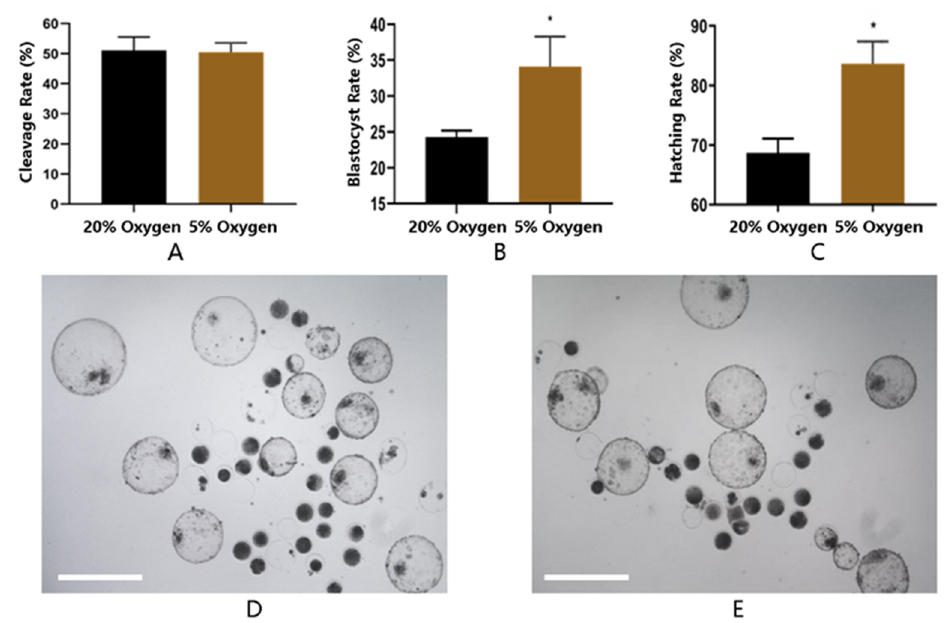
Figure 1. Effect of varying oxygen levels (20% vs. 5%) on embryo development. All the experiments were repeated three times. Embryos were cultured in 20% ( n = 180) or 5% ( n = 178) oxygen and assessed for cleavage on day 2 of culture. Oxygen did not influence the cleavage rate of embryos ( A ). Culture under 5% oxygen ( n = 567) improved the proportionate of the embryos developing to the blastocyst stage ( B ) and hatched blastocyst stage ( C ) as compared to 20% oxygen ( n = 576). The blastocyst and hatching rate were evaluated on day 7 of embryo development. Representative photographs of embryos cultured in 5% oxygen ( D ) and 20% oxygen ( E ). The images (1D and 1E) were captured with microscope (50i; Nikon, Japan) at 100× resolution. Asterisk (*) indicates the statistical difference ( p < 0.05) between the groups.